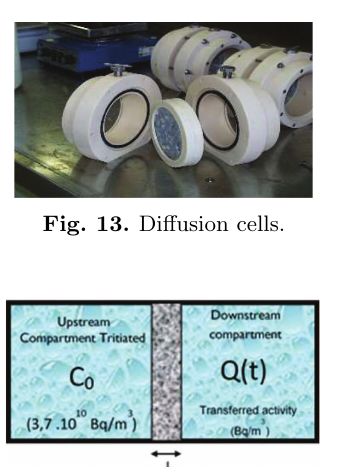
Fig. 14. Principle of measuring the diffusion coefficient.